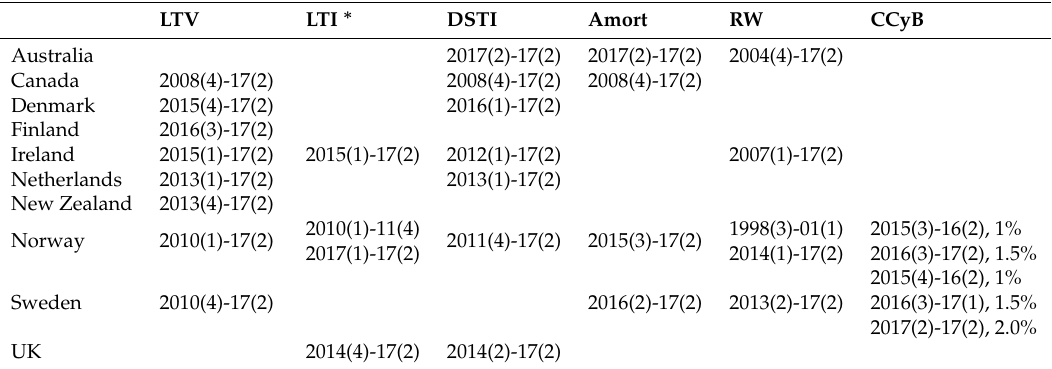
Table 1. Use of macroprudential policies in the estimation sample. The array elements indicate in which periods LTV, LTI, DSTI and Amort were used, in which periods RW was elevated, and the current level of CCyB in the various countries. Periods not entered and empty cells represent the numerical value 0. LTV LTI ∗ DSTI Amort RW